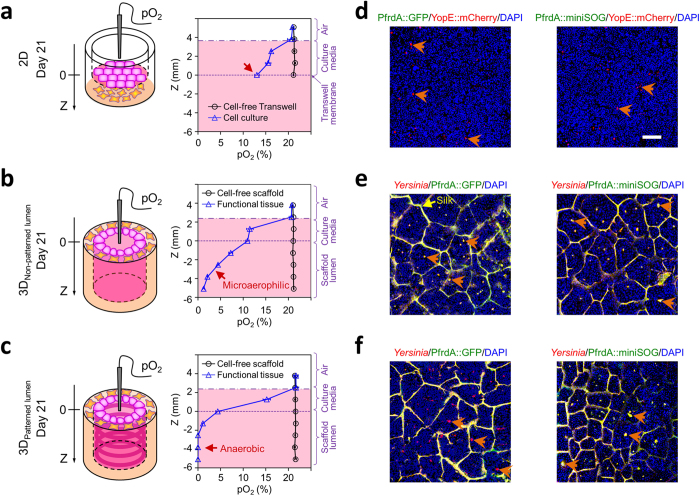
3D bioengineered human intestinal tissues mimic in vivo luminal oxygen levels.(a) Confluent intestinal epithelial monolayers cultured on transwell inserts under the aerobic condition. (b) Concentration profile of oxygen at different depths down the lumen of 3D tissues (with plain luminal surfaces) demonstrated ready access to microaerobic and nanaerobic oxygen concentrations. (c) The increased epithelial area in 3D tissues achieved by patterning the luminal surfaces further extended the low end of the oxygen profile to below the anaerobic threshold. All measurements were performed on day 21 post-confluence. (d) Red fluorescence of the yopE reporter (arrowheads) on transwell inserts, in the absence of frdA-driven green fluorescence (GFP or miniSOG), verified that bacteria experience aerobic conditions. (e) Yellow fluorescence (arrowheads) (mixed color of red anti-Yersinia and green GFP or miniSOG) in non-patterned lumens indicates bacteria experience microaerobic conditions. (f) Red Yersinia, detected by antisera, only expressed miniSOG (arrowheads), revealing bacteria experience strictly anaerobic conditions in patterned lumens. Scale bar = 50 μm.